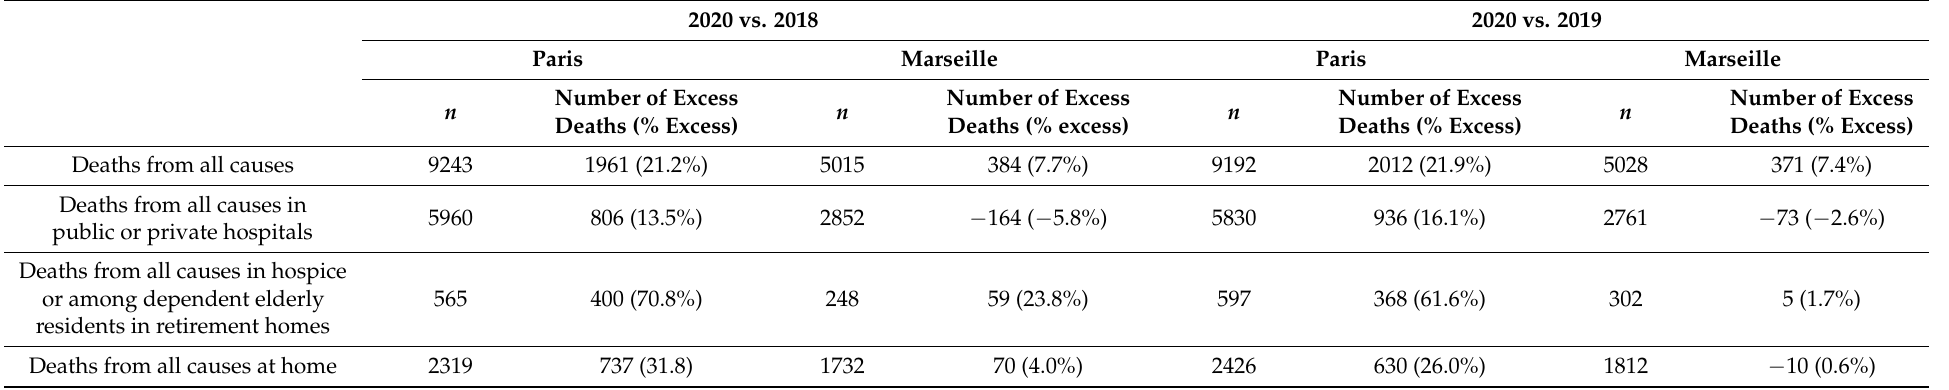
Table 4. Excess mortality in 2020 compared to 2018/2019 from January to August in Marseille and Paris. The data were collected from the INSEE